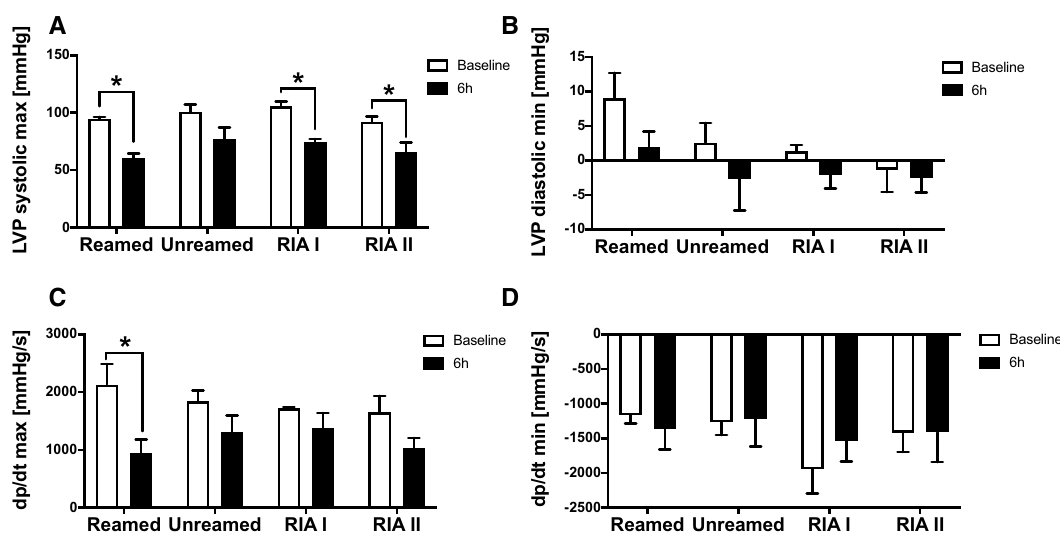
Figure 3. Blood pressure: ( A ) Systolic left ventricular pressure (LVP systolic max) in mmHg measured at BL (white) and 6 h after femur fracture in pigs and either nailing (unreamed) reaming (reamed), Reamer-Irrigator- Aspirator 1 (RIA1) or RIA 2. ( B ) Diastolic left ventricular pressure (LVP diastolic min) in mmHg bevor and after femur fracture. ( C ) dp/dt max measured in mmHg/s. ( D ) dp/dt min in mmHg at baseline and 6 h after femur fracture and treatment. n = 5 in each group, data were presented as ± SEM, *p ≤